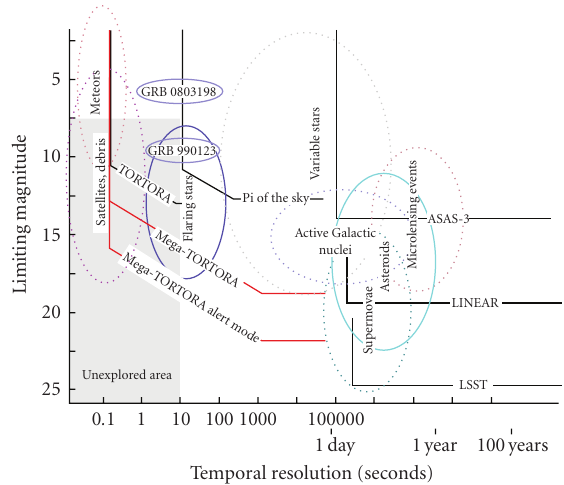
Figure 11: Performance of MegaTORTORA, as well as several others typical wide-field monitoring projects both in operation now (ASAS-3, LINEAR, Pi of the Sky, FAVOR/TORTORA) and planned for near future (LSST), in observations of di ff erent classes of variable